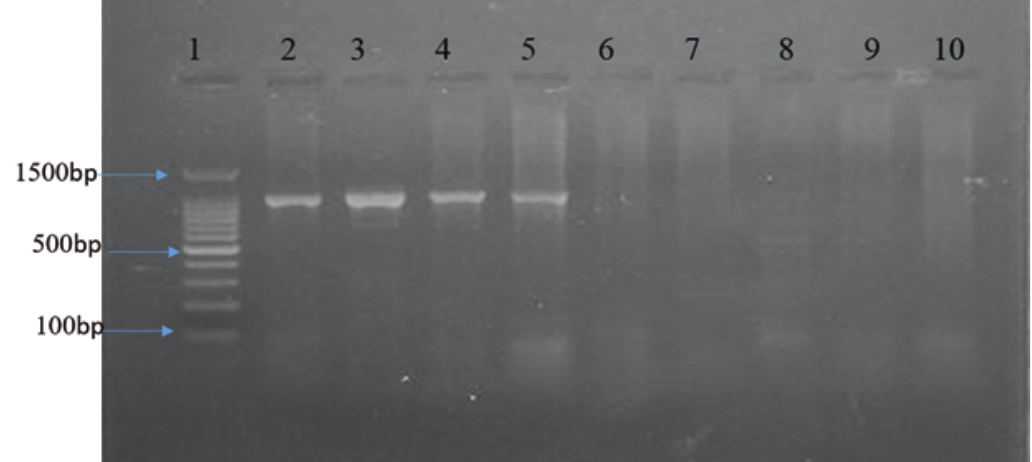
Figure 2: Amplification of TEM genes. Lane 1 DNA marker (100–1500bp), lane 2 positive control, lanes 3–5 were positive for TEM (971 bp), lanes 6–10 are negative samples.